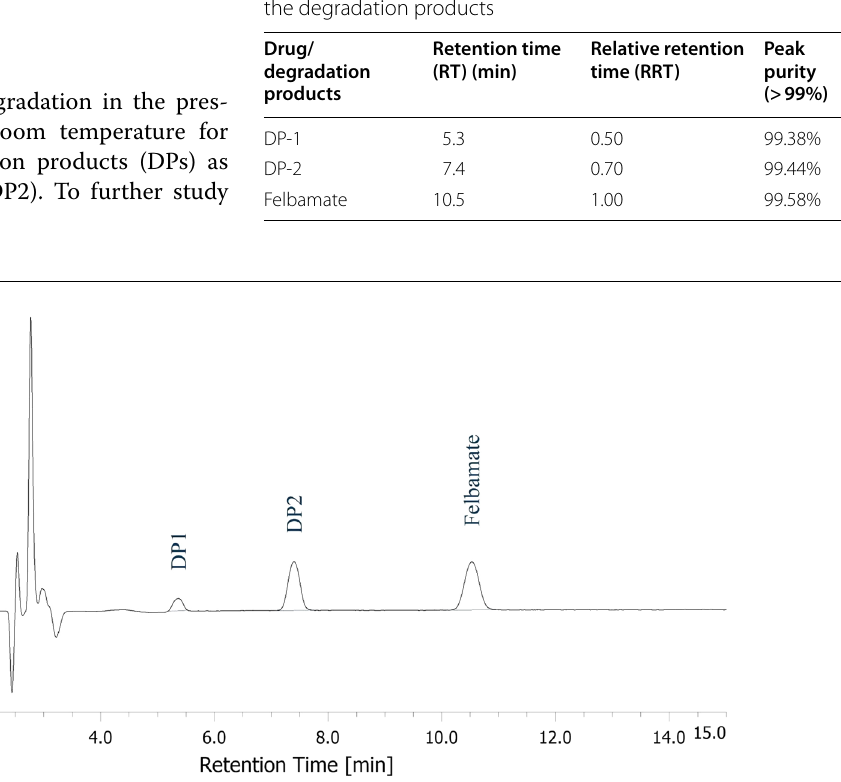
Fig.2 Chromatogram of the drug and the DPs under the alkaline condition at RT